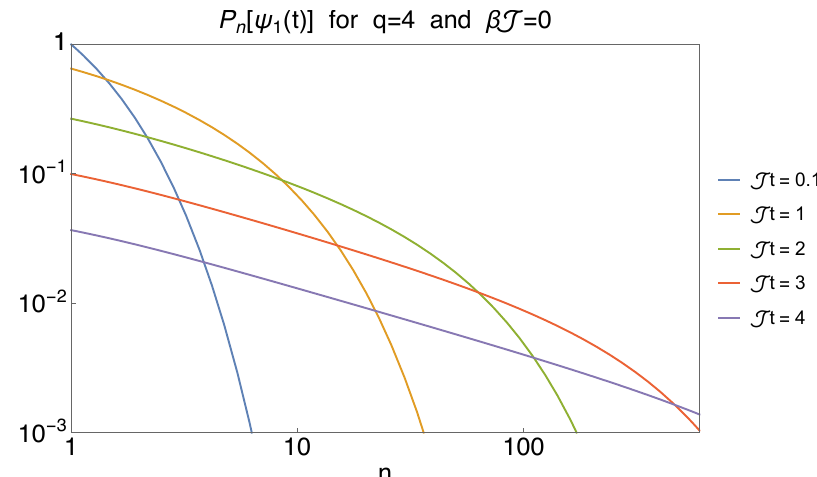
Figure 8 . After either dynamical renormalization (5.12) or time re-parametrization (5.13), the growth distribution K (cid:12) [ 1 ( t )] takes the same form as the Heisenberg evolution of the operator 1 ( t ) (i.e. the in(cid:12)nite temperature size distribution P [ 1 ( t )]). This distribution is given by eq. (5.14), and we plot it on a log-log scale. Note that it reaches out towards larger operators exponentially quickly.